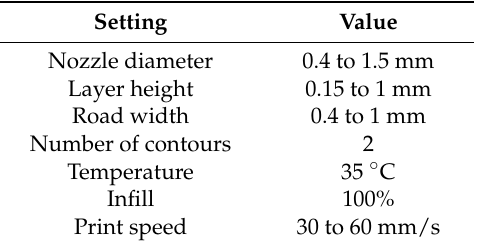
Table 2. Printing